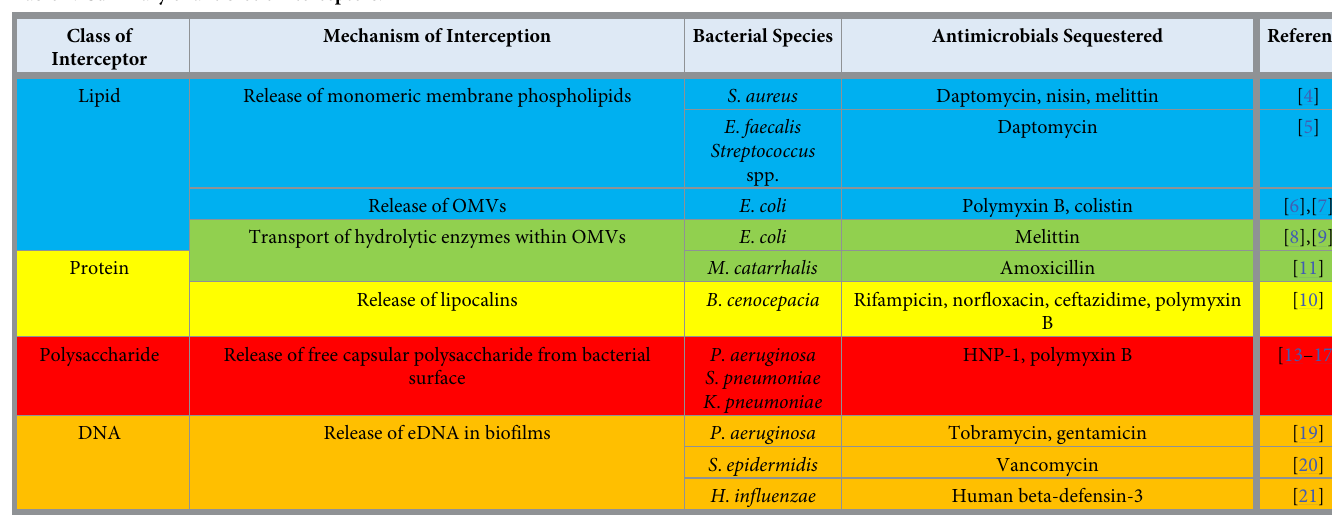
Table 1. Summary of antibiotic interceptors.